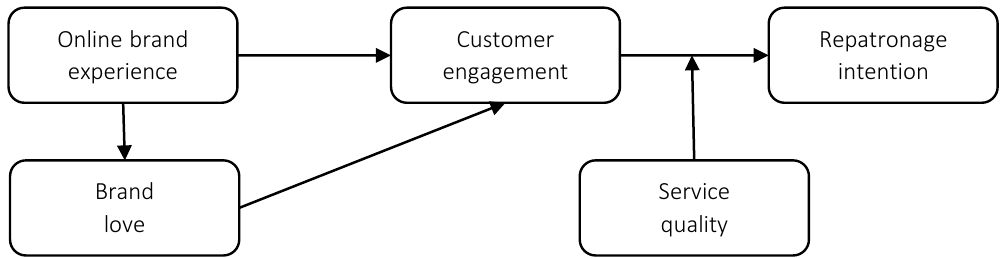
Figure 1. Elaborated